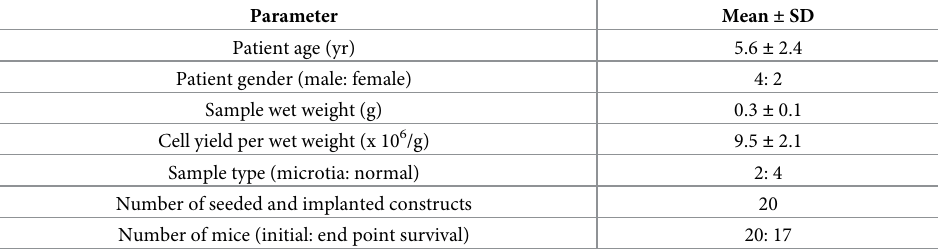
Table 1. Human surgical biopsy details for auricle